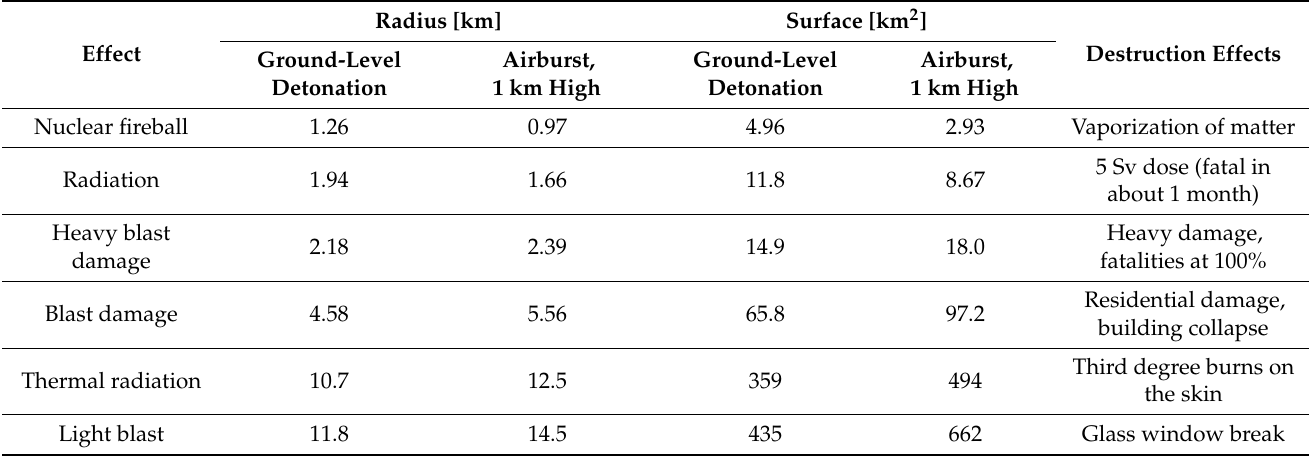
Table 2. A nuclear weapon (1 Mt) simulation (first scenario) of effects based on the NukeMap